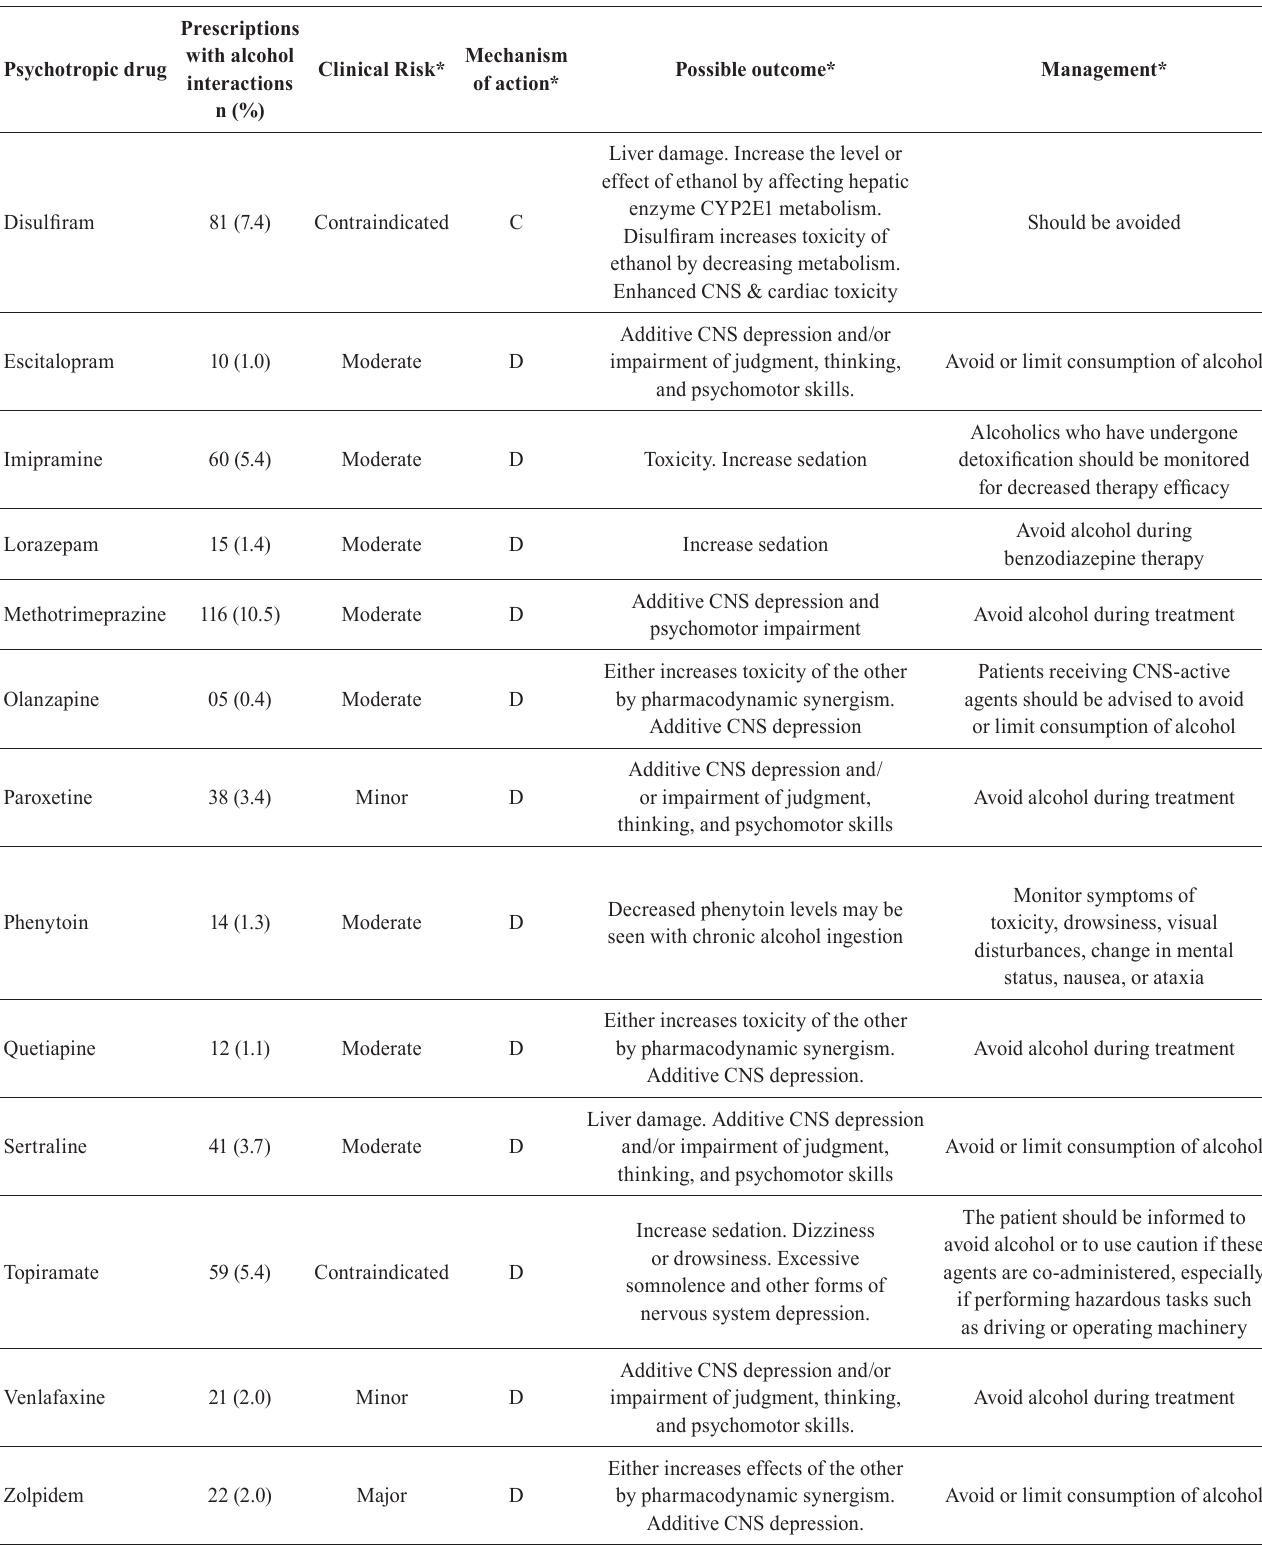
TABLE II - Frequency of prescriptions with drug interactions between psychotropics drugs and alcohol and tobacco Prescriptions with alcohol Mechanism Psychotropic drug Clinical Risk* Possible interactions of action*